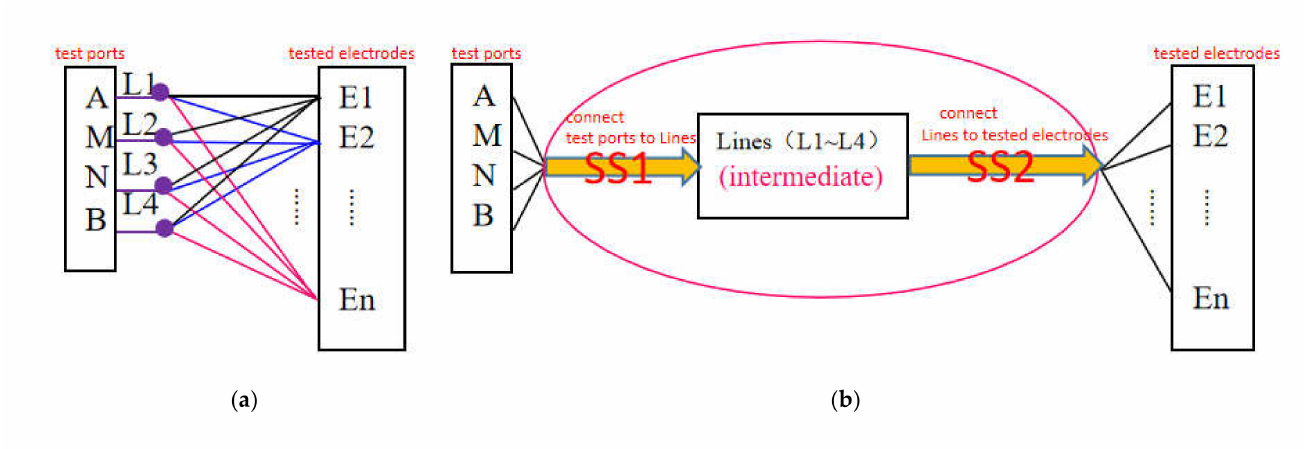
Figure 4. System structure of ESD and the system structure of TESD ( a ) [24]; desire to realize the system structure of HESD ( b ). ( a ), Each group of colored lines represents the connection to each electrode, respectively. ( b ), SS1: switch structures 1; SS2: switch structures